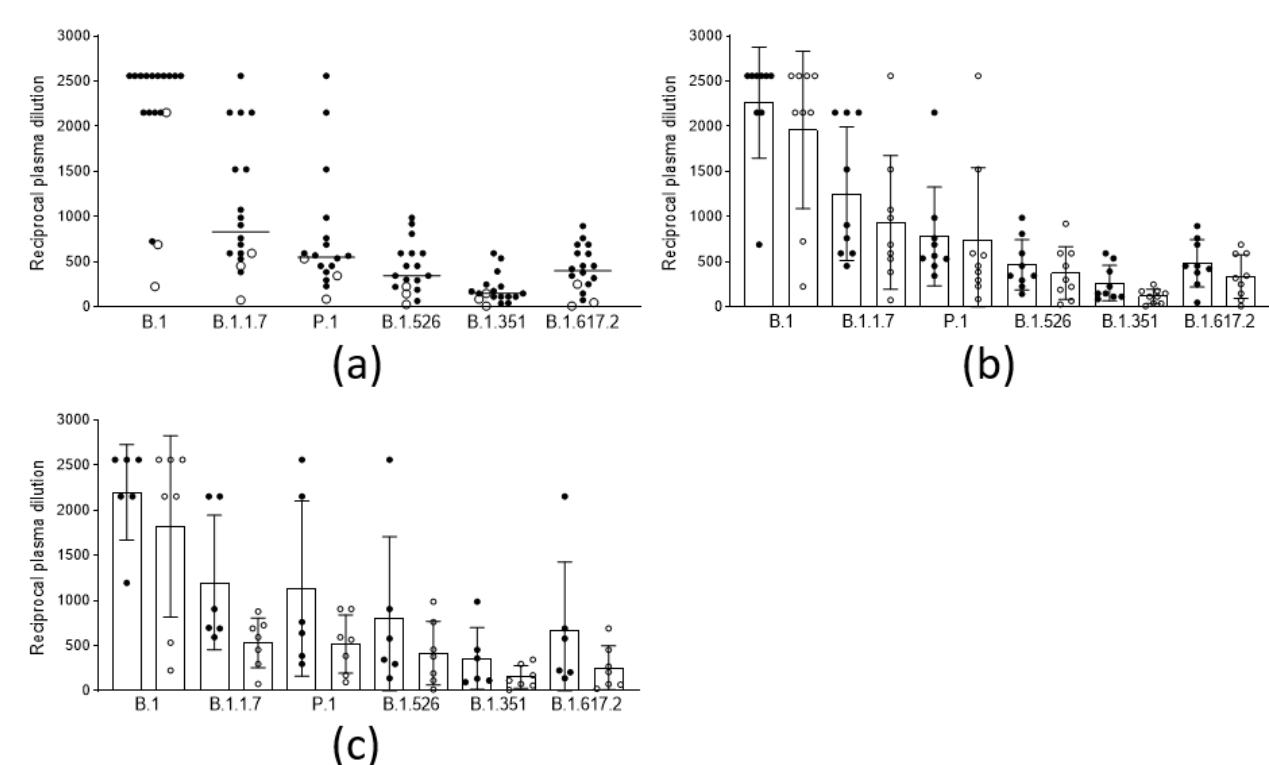
Figure 3. Neutralization titers of sera from vaccinees with anamnestic response and immunological memory who had already experienced PCR-confirmed SARS-CoV-2 infection against different viral lineages. ( a ) Neutralization titers of subjects vaccinated with 2 doses of the BNT162b2 (black circles, n = 15), and the AZD1222 (white circles, n = 3), vaccines against 6 viral lineages of SARS-CoV-2. Horizontal lines represent medians. ( b ) Neutralization titers against 6 viral lineages of 9 subjects infected between February and April 2020 (black circles) compared to those of 9 subjects infected between October and December 2020 (white circles), both vaccinated with 2 doses of vaccine. Columns represent means, and error bars represent the standard deviation. Reductions of neutralizing titers were not statistically significant. ( c ) Neutralization titers against 6 viral lineages of 6 subjects infected between February and April 2020 (black circles), compared to 7 subjects infected between October-December 2020 (white circles), both vaccinated with 1 dose of vaccine. Columns represent means, and error bars represent the standard deviation. Reductions of neutralizing titers were not statistically significant. Statistical difference was assessed by the Mann-Whitney rank test. Neutralization titers <20 and >1280 were plotted as 10 and 2560, respectively.